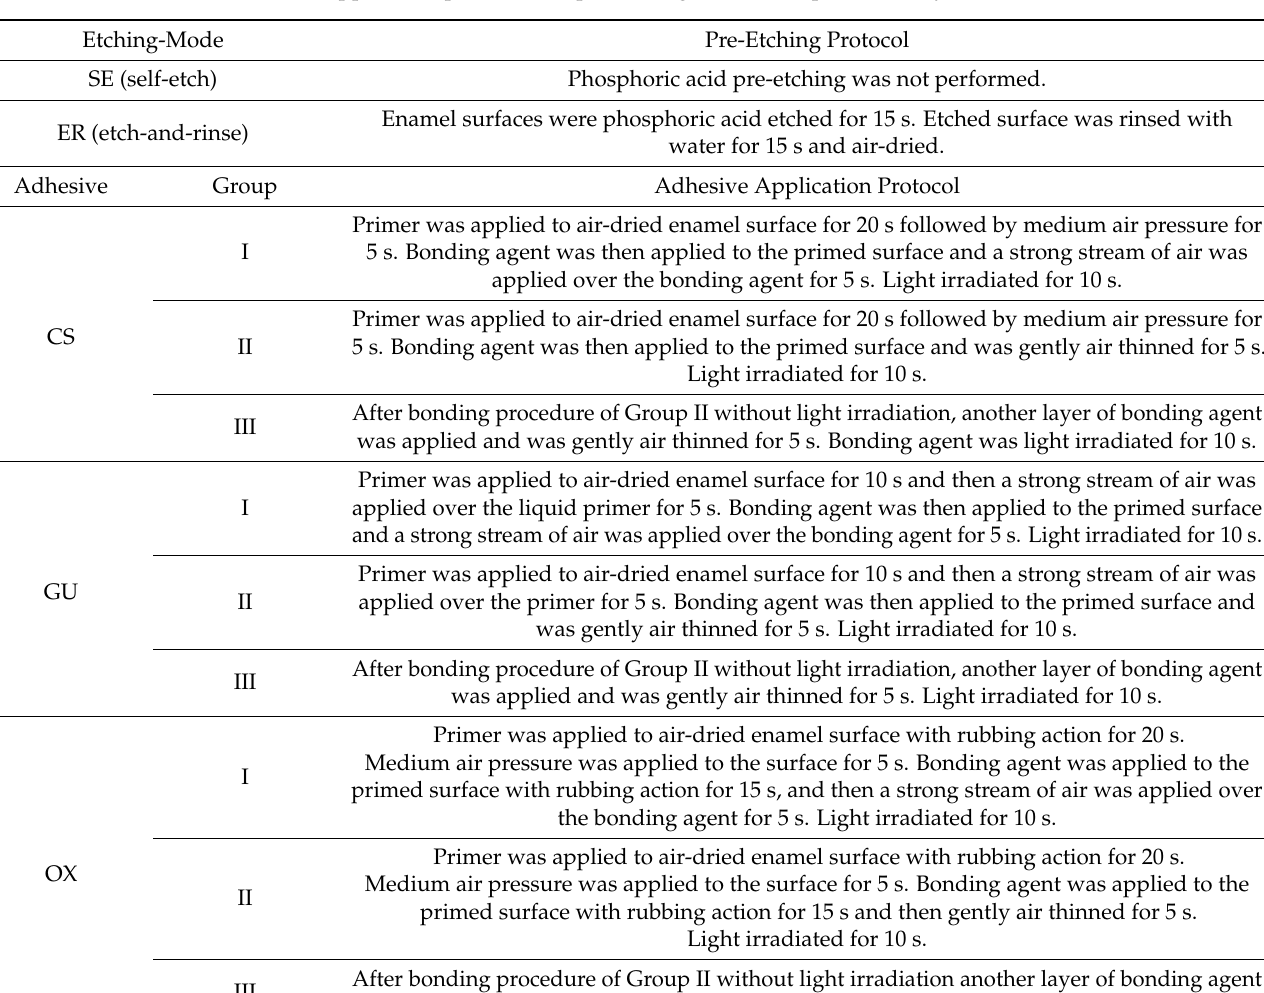
Table 2. Application protocols for pre-etching and two-step adhesive